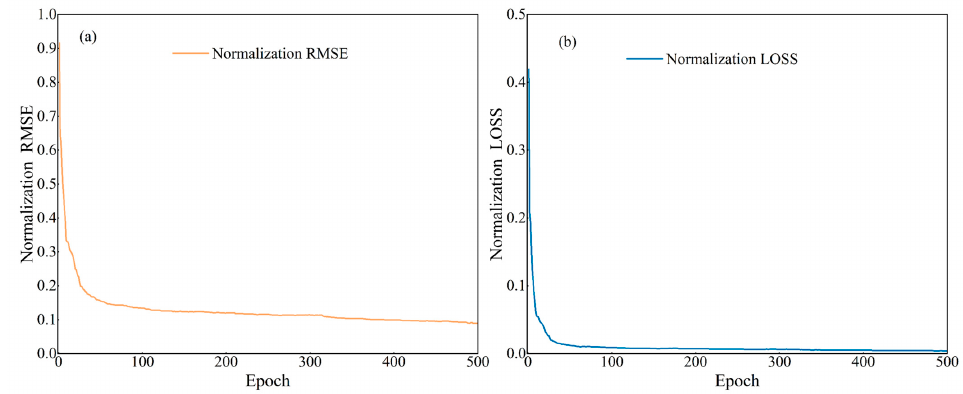
Figure 8. The training period results of LSTM model at Pochengzi hydrological station. ( a ) normalized RMSE and ( b ) normalized loss function.